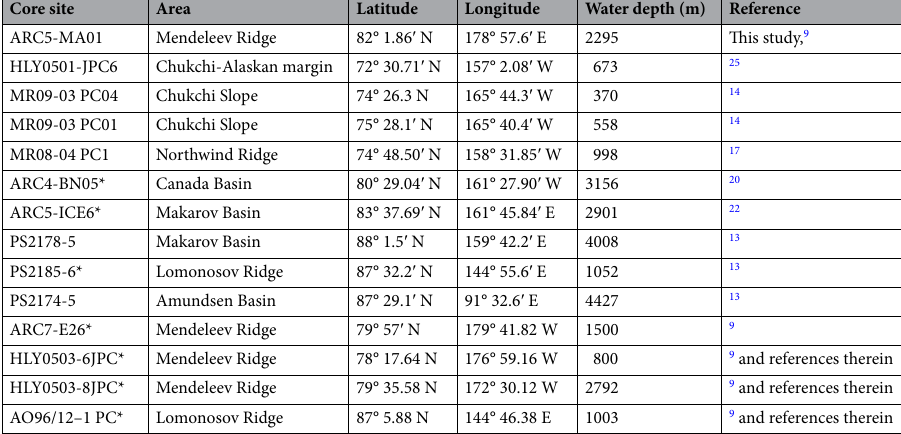
Table 1. List of cores in this study and reference cited. The cores marked with asterisk were used in the previous study 9 for regional stratigraphic